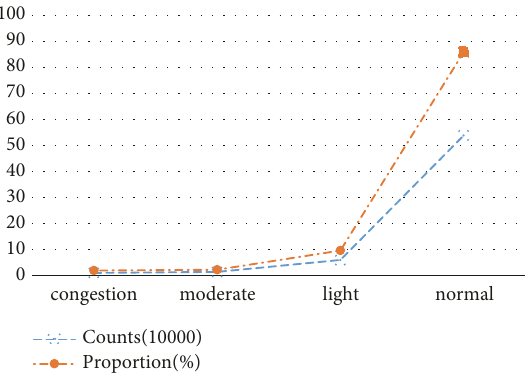
Figure 3: The counts and proportions of different congestion levels in the training data.